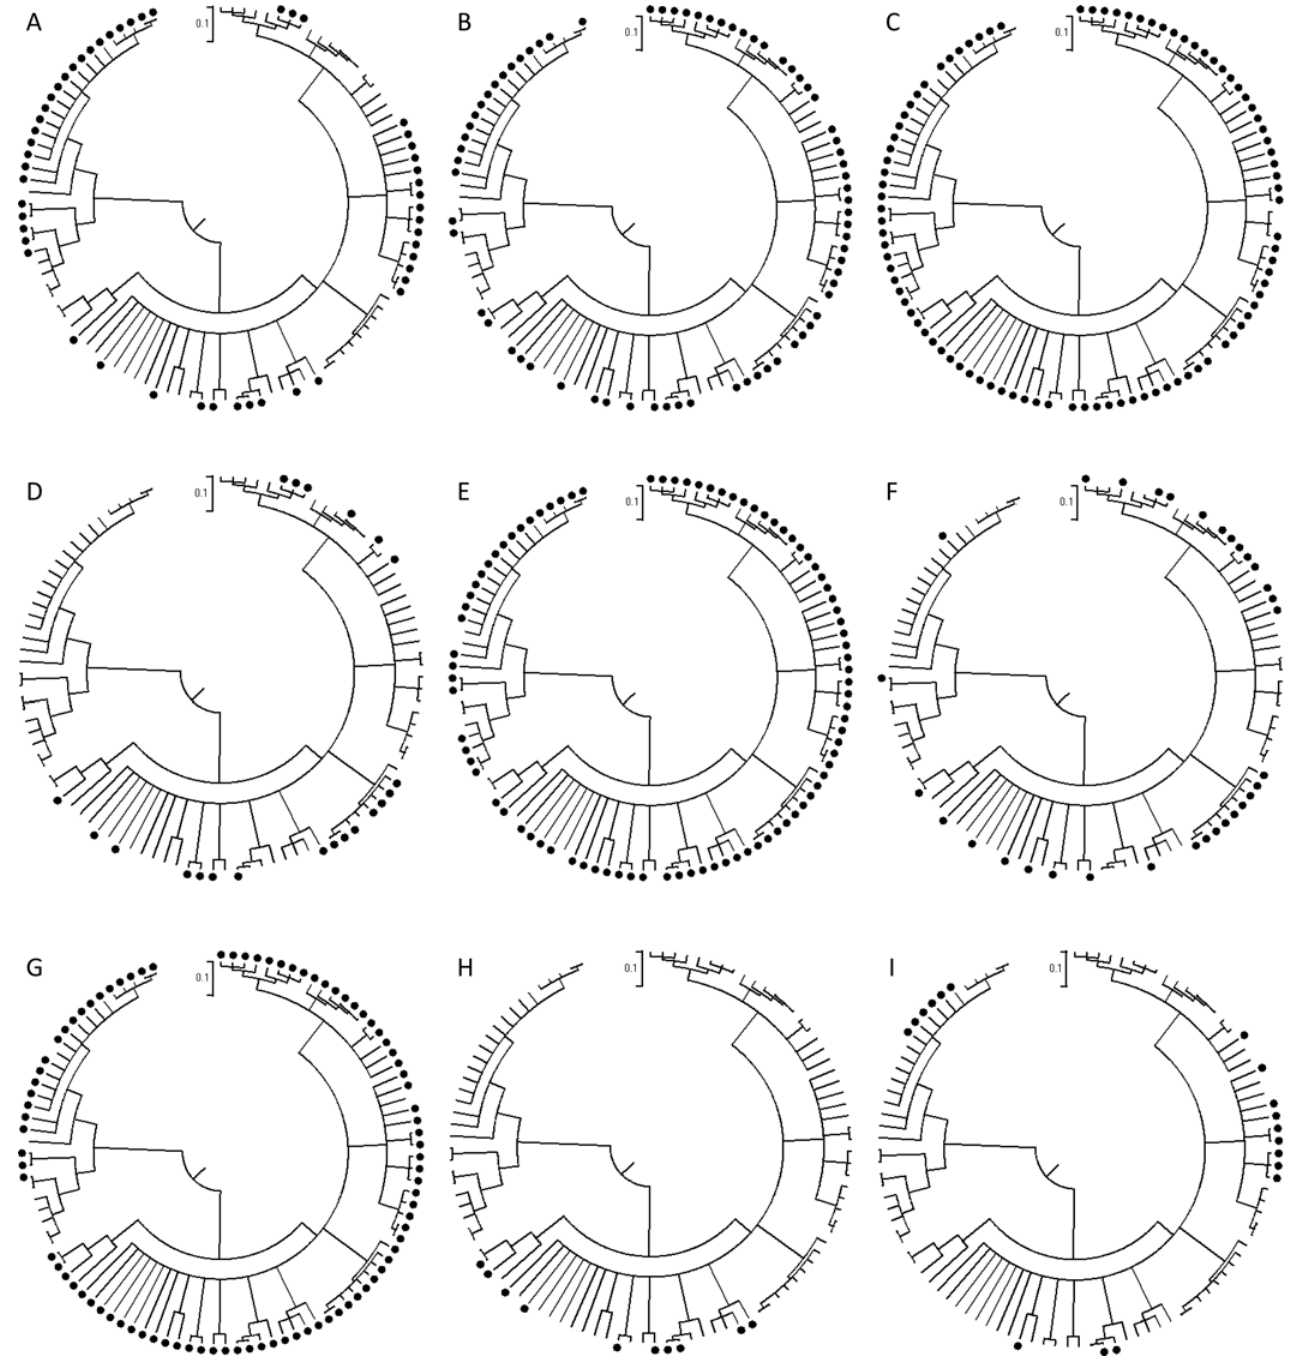
Fig 5. rMLST CLONALFRAME genealogies of Clade A showing the presence of specific genes in the isolates: (A) icaADBC , (B) aap , (C) embp , (D) bhp , (E) sdrF , (F) sesC , (G) s esE , (H) sesG , (I) sesH/ sesI . atlE , aae , ebpS and fbe/sdrG were present in all isolates. The scale bar (0.1) indicates the genetic distance in coalescent